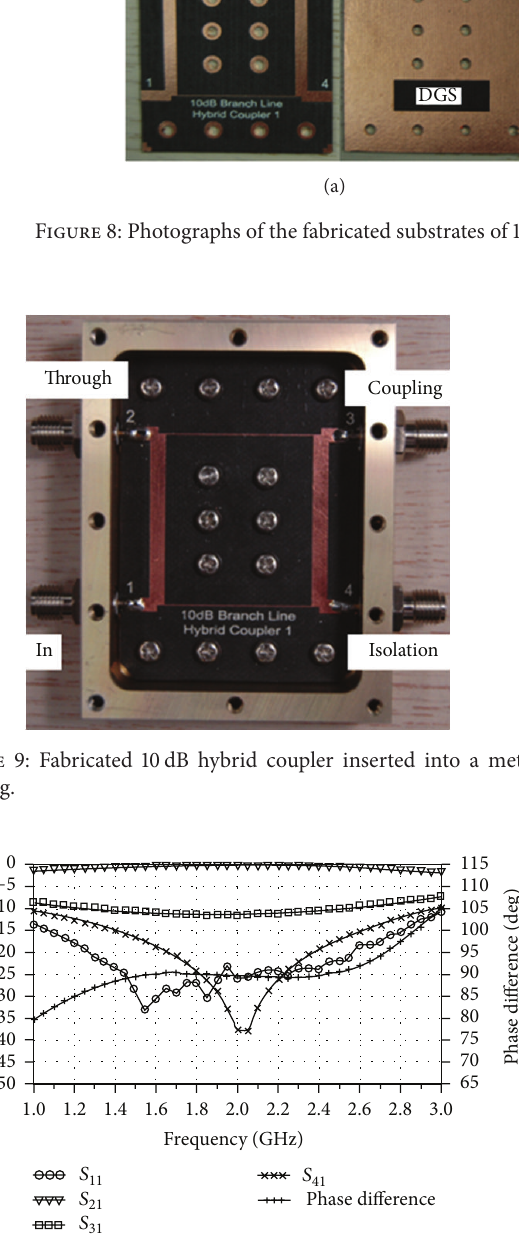
Figure 10: Measured 𝑆 -parameters of the fabricated 10dB branch line hybrid